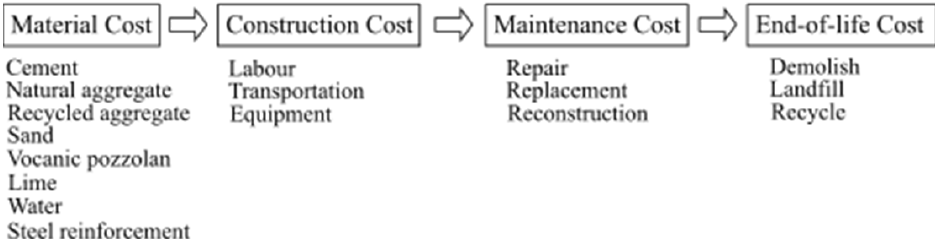
Figure 9. Life cycle cost analysis.